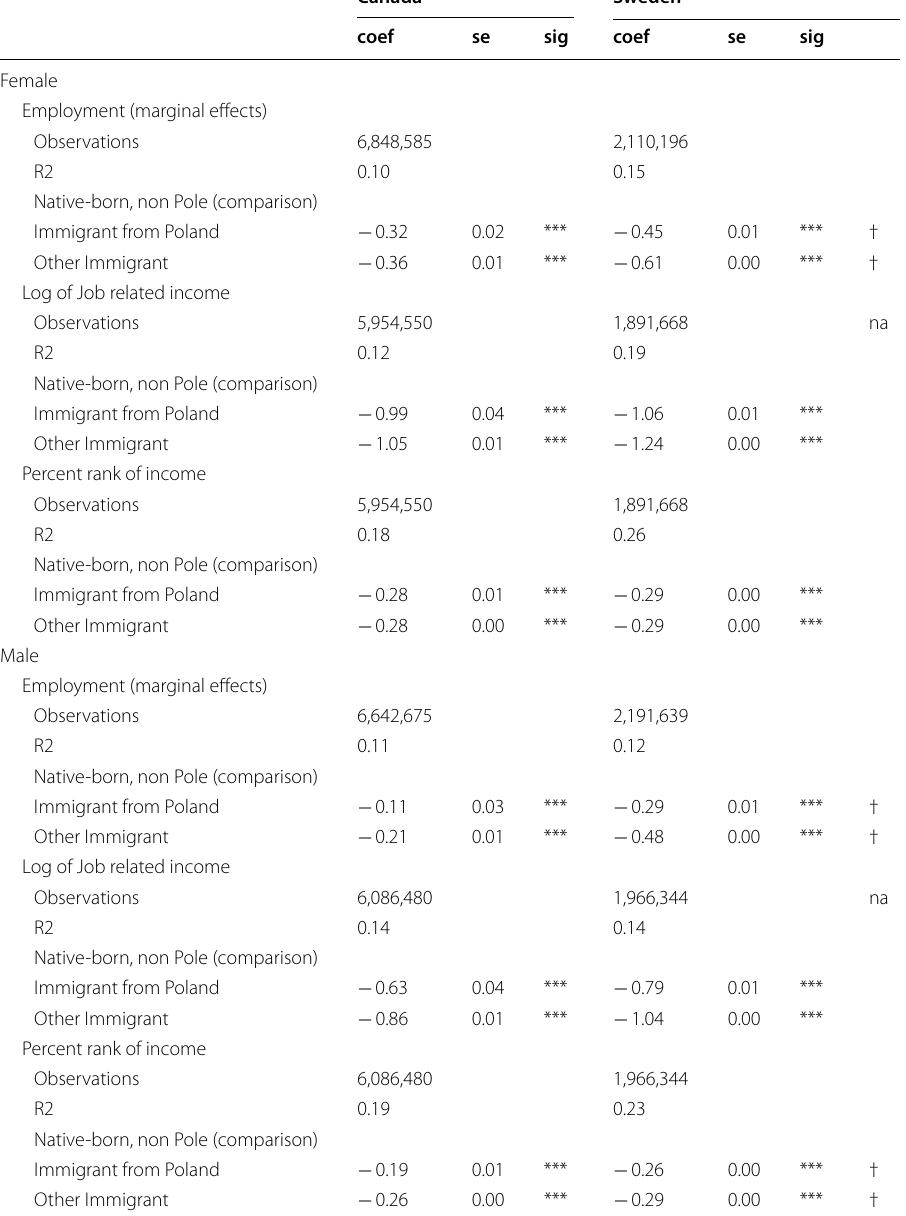
Table 7 Employment and income differentials for selected groups, native born and immigrants arriving from 2004 to 2014, Canada and Sweden,